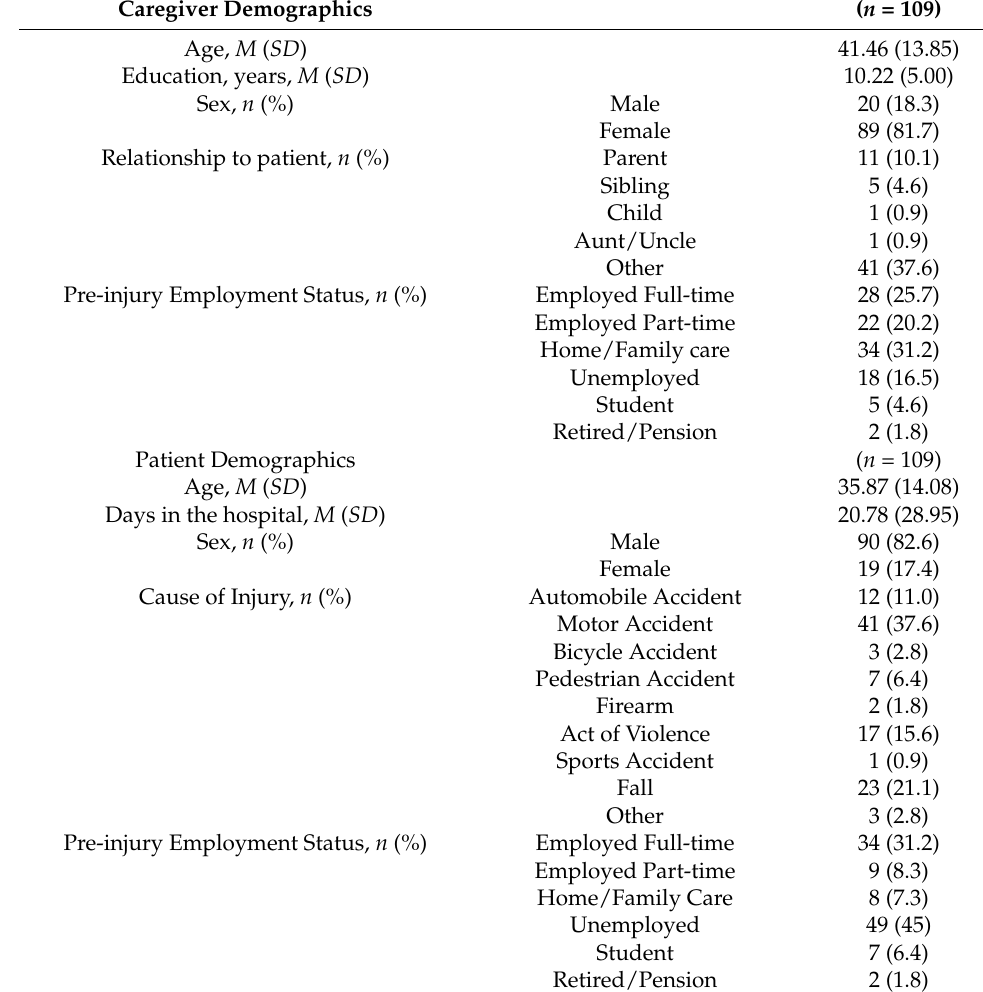
Table 1. Sample means, SDs, and percentages of demographic